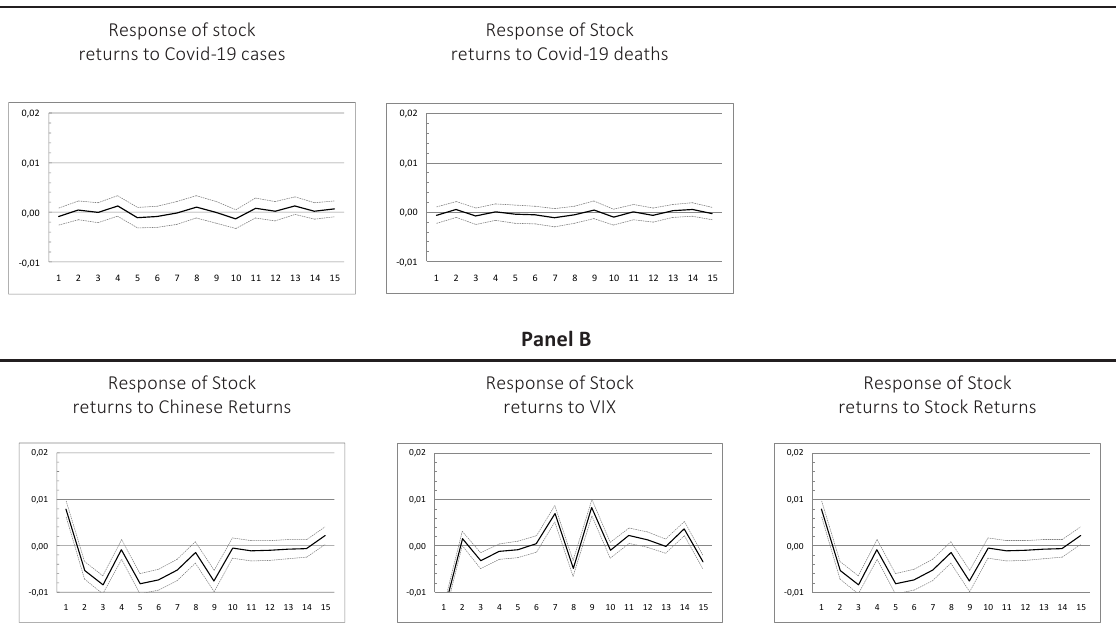
Figure 3. Generalized impulse response of European stock returns to COVID-19 cases and deaths, Chinese returns and VIX